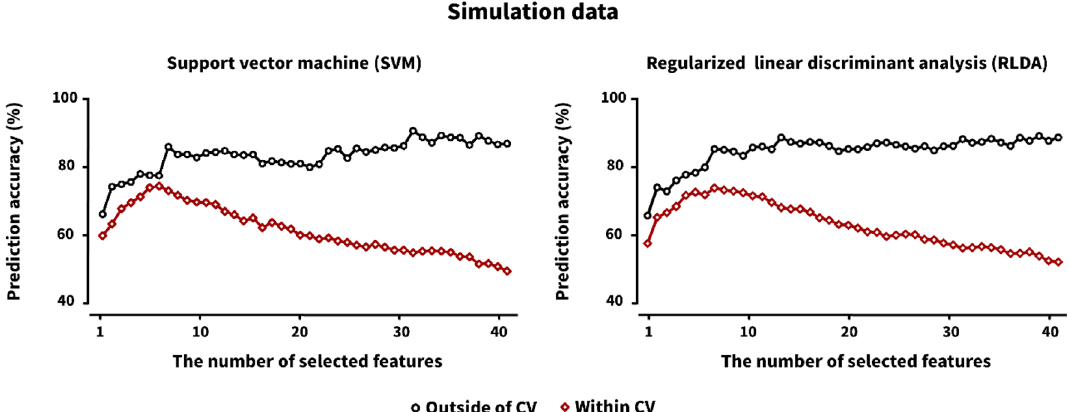
Figure 2. Prediction accuracies of two different feature selection approaches (outside of CV and within CV) for SVM and RLDA (unit: %) with respect to the number of selected features for the simulation data. Note that features were sequentially selected with higher votes, and the corresponding features were independently used to estimate prediction accuracies for each feature number. As the number of features selected by the within CV feature selection method varied in each CV loop, we averaged the prediction accuracies of a specific number of features selected in each CV loop. However, features fixed after the feature selection performed outside of CV were used to estimate prediction accuracies as a function of the number of features.